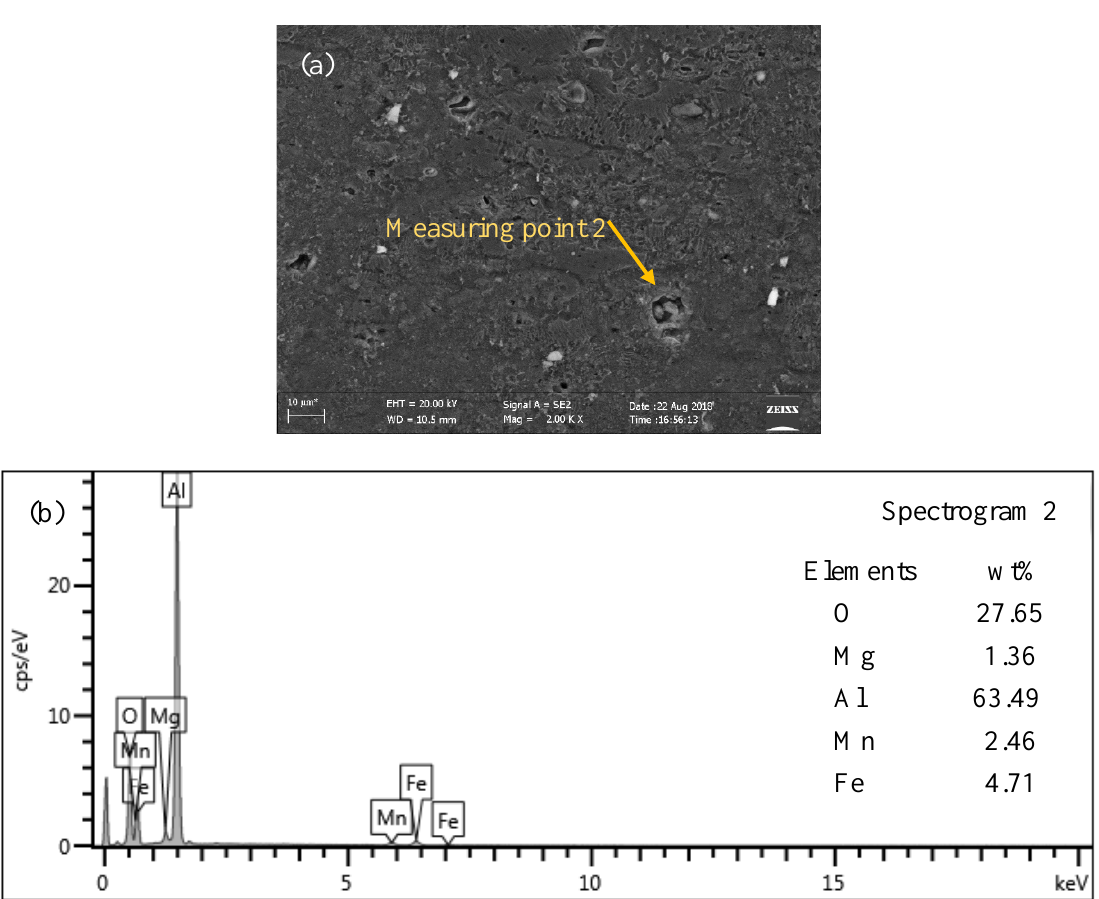
Figure 14. Scanning electron microscopy (SEM) analysis of precipitates with synchronous water-cooling: ( a ) measurement position; ( b ) spectrogram.